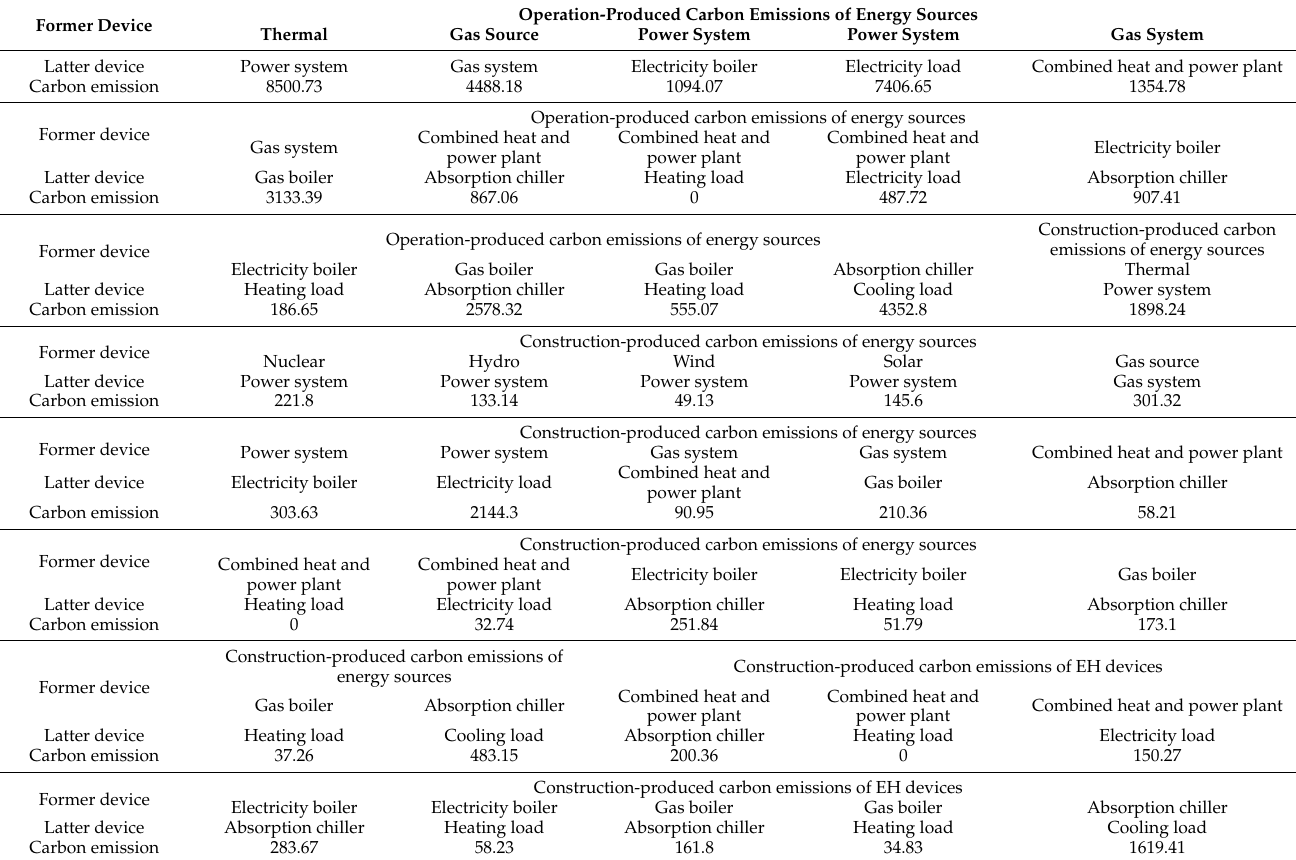
Figure 5. The carbon emission flow of the UMES on a summer weekday. Table 6. Carbon flow of EH devices throughout the day of a summer weekday (kg).